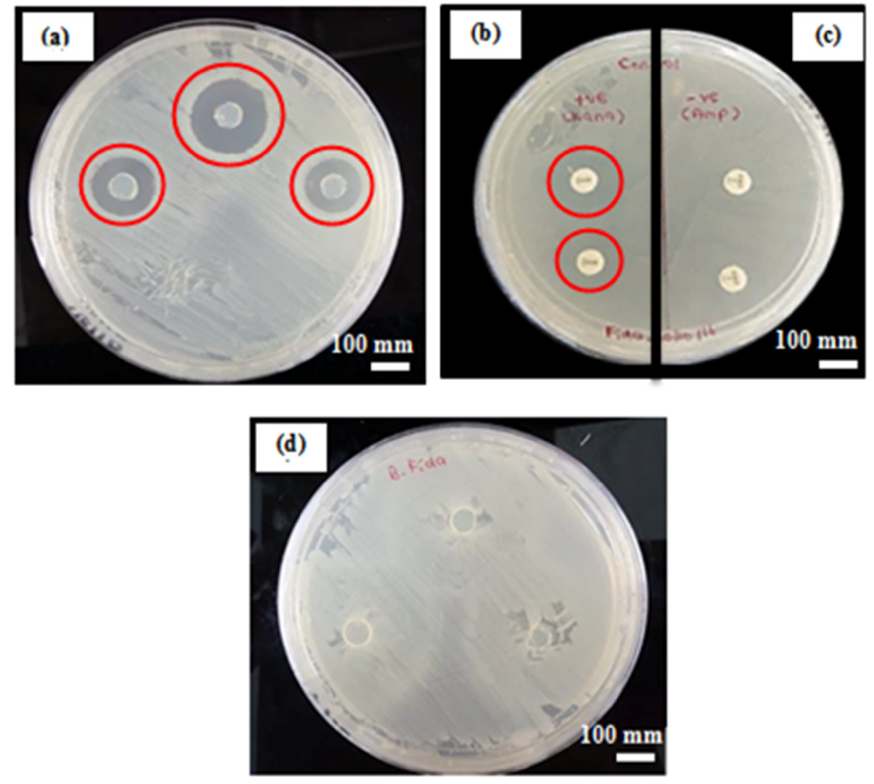
Figure 6. The appearance inhibition zone after 18 h of incubation for ( a ) GG-Carv 08, ( b ) positive control (Kanamycin), ( c ) negative control (Ampicillin) and ( d ) pure GG.